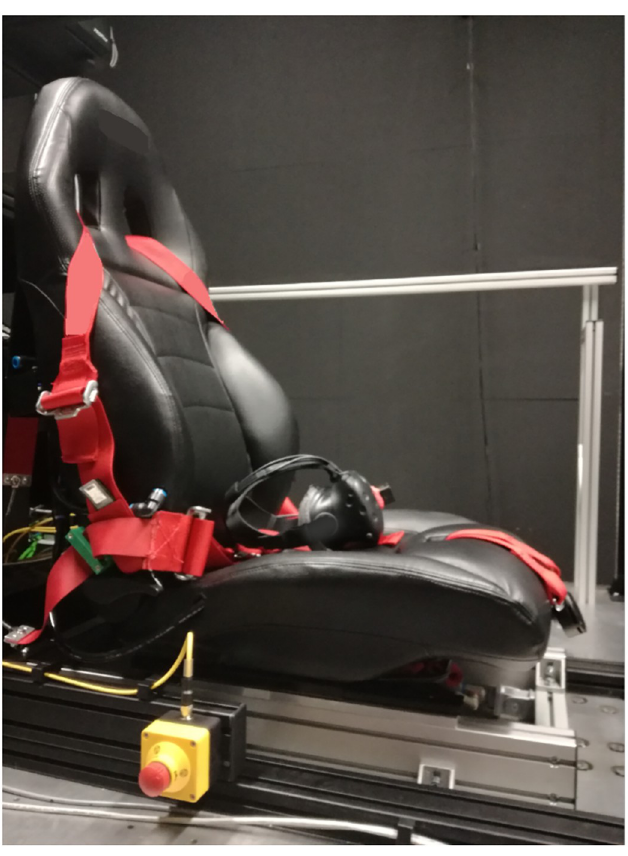
Fig 1. Active seat. The AS mounted on the motion platform with 6-point AB and Head-Mounted Display